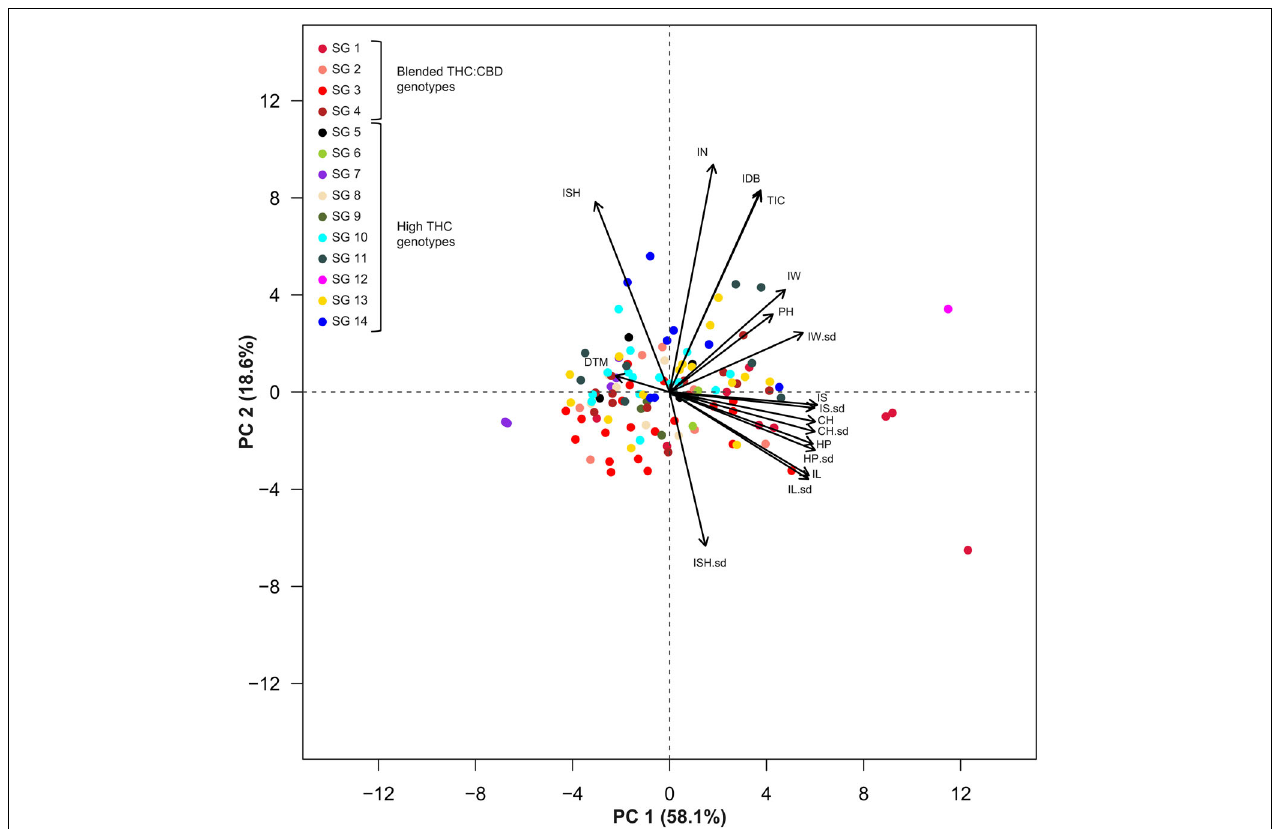
FIGURE 5 | Principal Component Analysis (PCA) for 119 genotypes across 14 Inflorescences’ attributes and three physiological parameters. Colors indicate genotypic classifications into strain groups (SG) according to vernacular affiliations (for example, “Banana Kush” or “Diesel”). Genotypes marked in red (or a red shade) are characterized with a blended THC:CBD ratio while all other colors indicate high-THC genotypes (plants cannabinoid classification was assessed through DNA markers). Abbreviations: Inflorescence Size (IS), Inflorescence Size standard deviation (IS.sd), Convex Hull (CH), Convex Hull standard deviation (CH.sd), Hull Perimeter (HP), Hull Perimeter standard deviation (HP.sd), Inflorescence Length (IL), Inflorescence Length standard deviation (IL.sd), Inflorescence Width (IW), Inflorescence Width standard deviation (IW.sd), Total Inflorescence Coverage (TIC), Inflorescence Number (IN), Inflorescence Shape (ISH), Inflorescence Shape standard deviation (ISH.sd), Inflorescence Dry Biomass (IDB), Plant Height on harvest day (PH), Days To Maturation